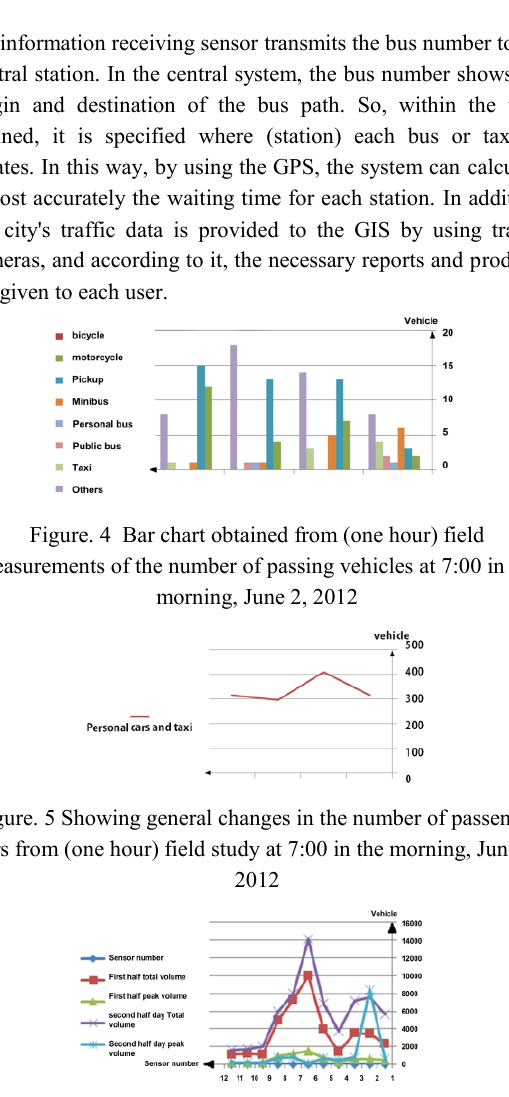
Figure. 6 Output changes from the sensors in Khayyam junction in Mashhad on July 13, 2012